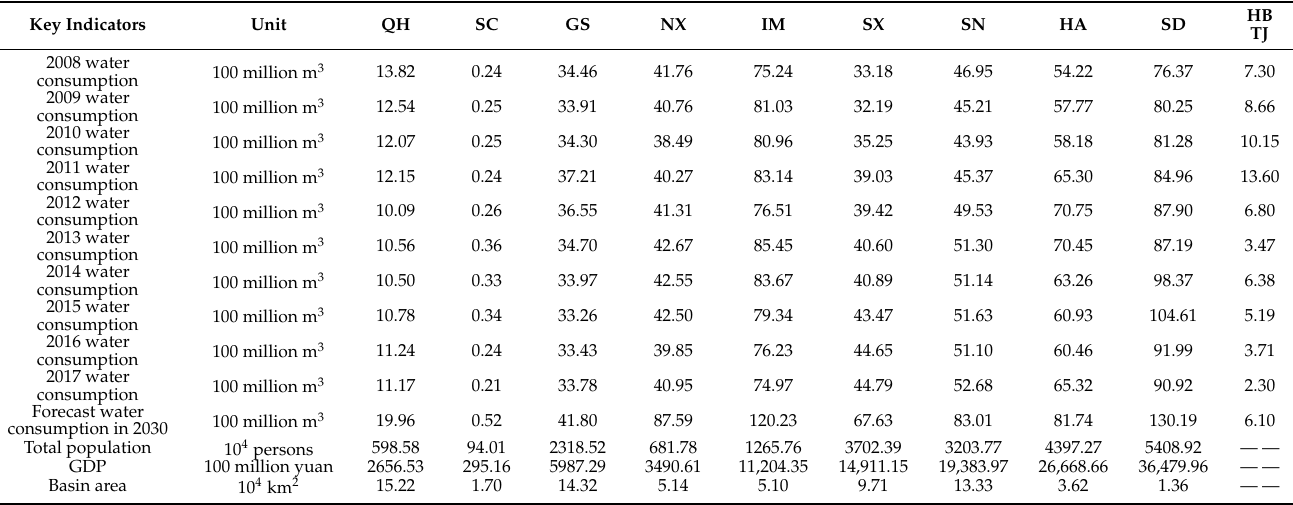
Table 1. Calculation of raw data for the new water distribution scheme for the Yellow